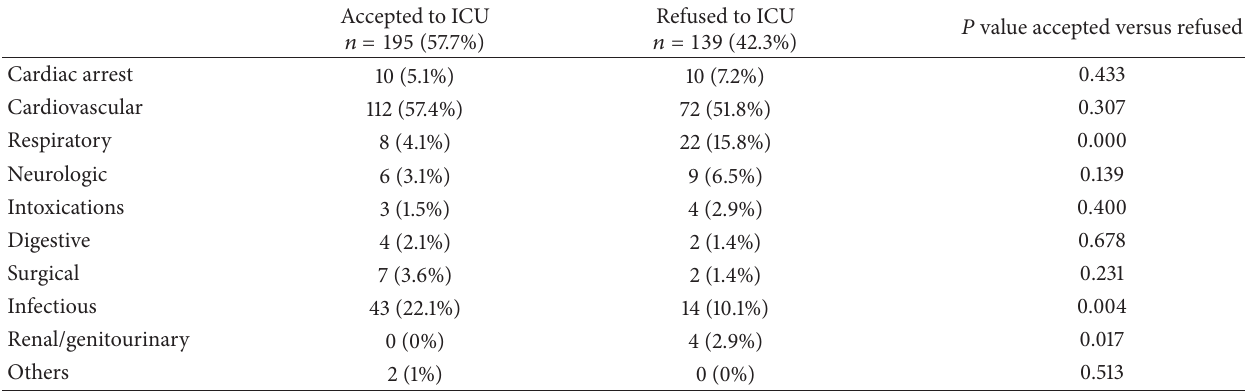
Table 2: Main reason for patient evaluation at first ICU triage.